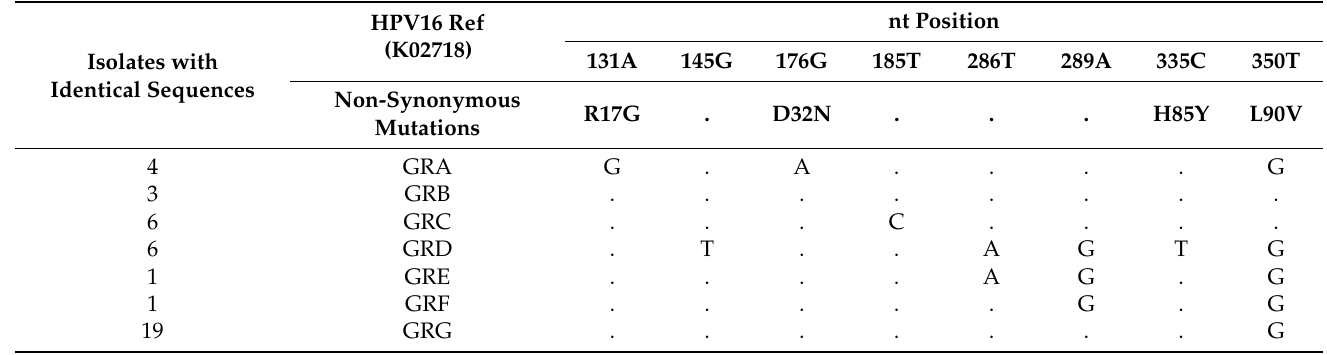
Table 1. Nucleotide variations in HPV16 E6 ORF. A, adenine; T, thymine; G, guanine; C, cytosine; . absence of nucleotide variation or amino acid